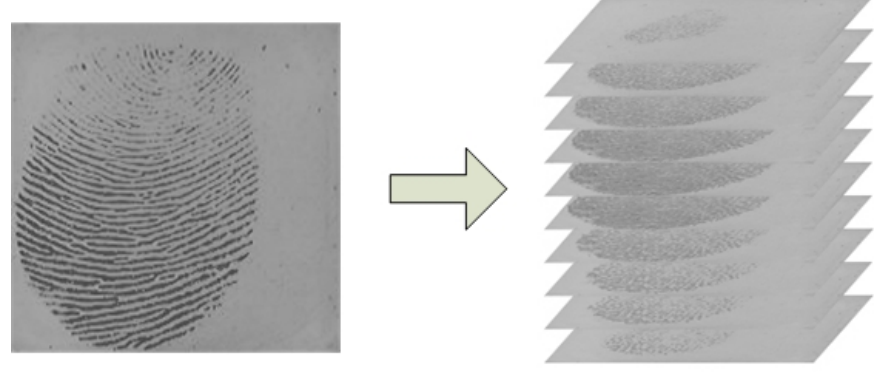
Figure 1. From static image (a single impression) to video (a fingerprint